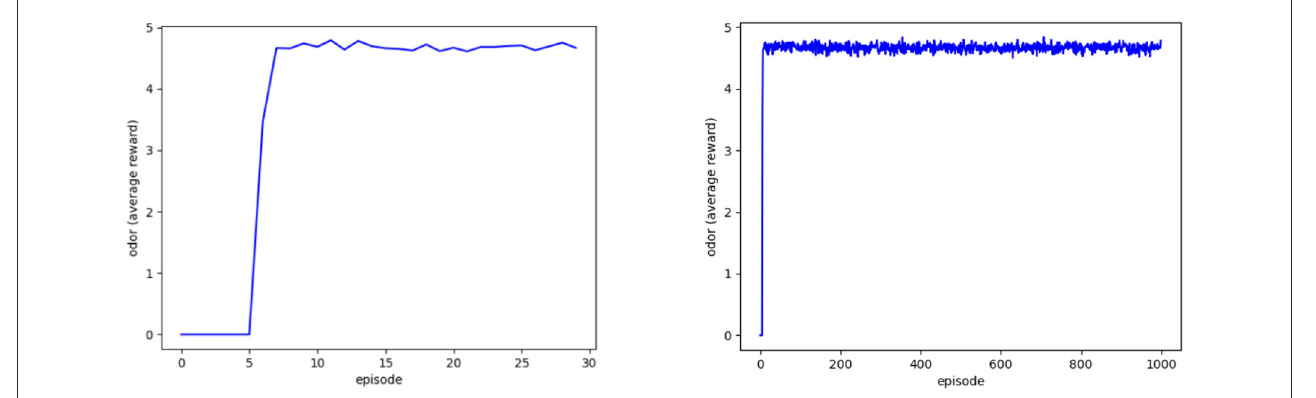
FIGURE8 Agent’s average reward at 30 (left) and 1,000 episodes (right)